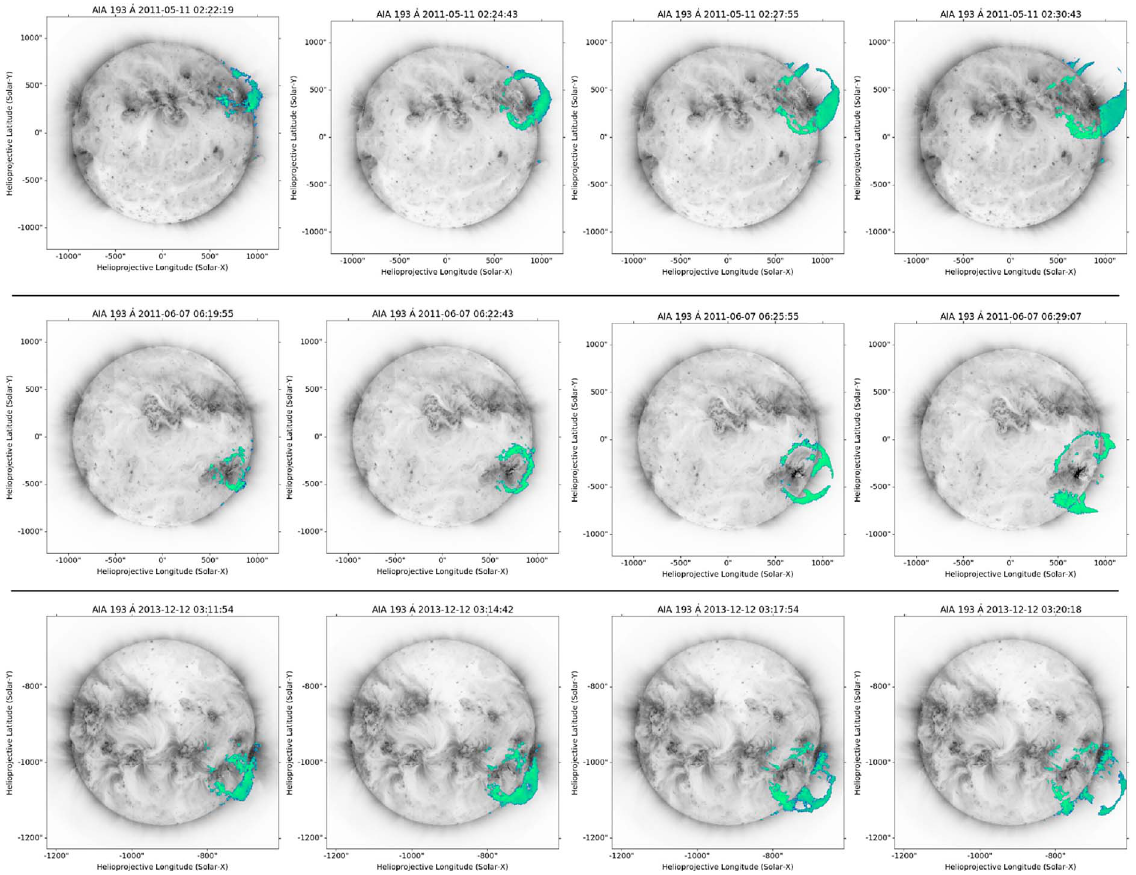
Fig. 4. The Output of the Wavetrack method for three separate CBF events: May 11, 2011; June 07, 2011; December 12, 2013. For each event, we show four snapshots of inverted-colormap grayscale AIA 193Å images, with the Wavetrack CBF masks applied to base difference data overlaid using a different colormap to highlight them.